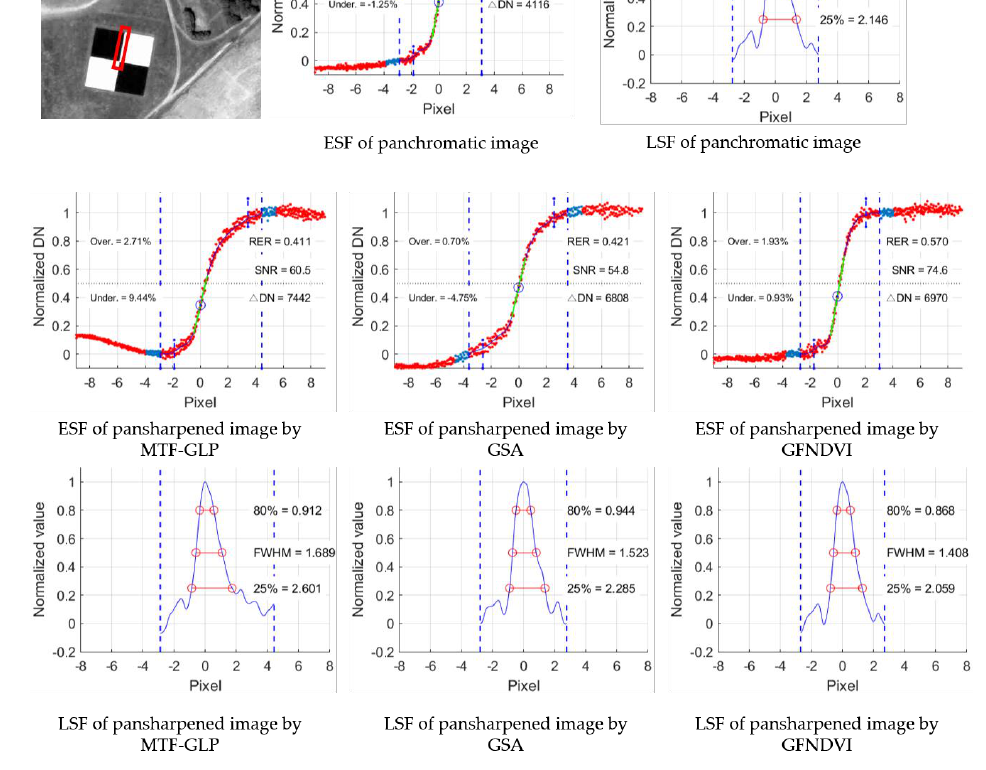
Figure 10. The edge spread function (ESF) and line spread function (LSF) curves in the cross direction according to the pansharpened image generated by each algorithm (Salon region). DN: digital number; RER: relative edge response; SNR: signal-to-noise ratio.